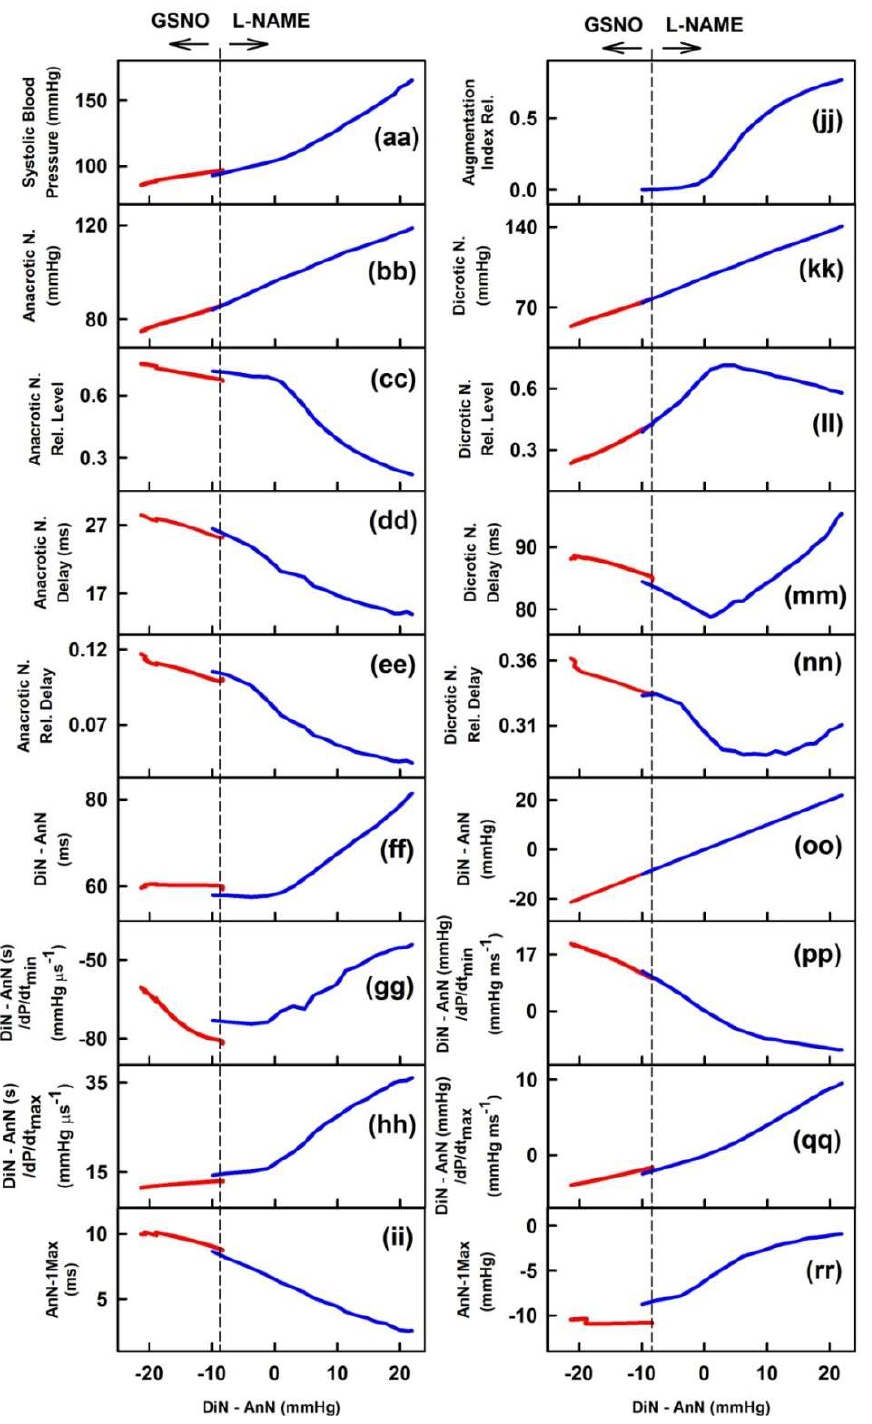
Figure 6. Two-dimensional cross-relationships of DiN-AnN pressure difference (in mmHg) to 34 rat HPs for conditions of increased/decreased NO bioavailability. The increase of NO bioavailability was caused by i.v. administration of 32 nmol·kg − 1 GSNO (red line; average from 10 experiments; data calculated from Figure 6 published in [22]). Red line was calculated from the time segment during which BP decreased after GSNO administration. The decrease of NO bioavailability after i.v. administration of 25 mg·kg − 1 l -NAME (blue line; average from six experiments; data calculated from Figure 3 published in [23]) is shown. Blue line was calculated from the time segment during which BP increased after l -NAME administration. Arrows indicate the time direction after GSNO and l -NAME administration.